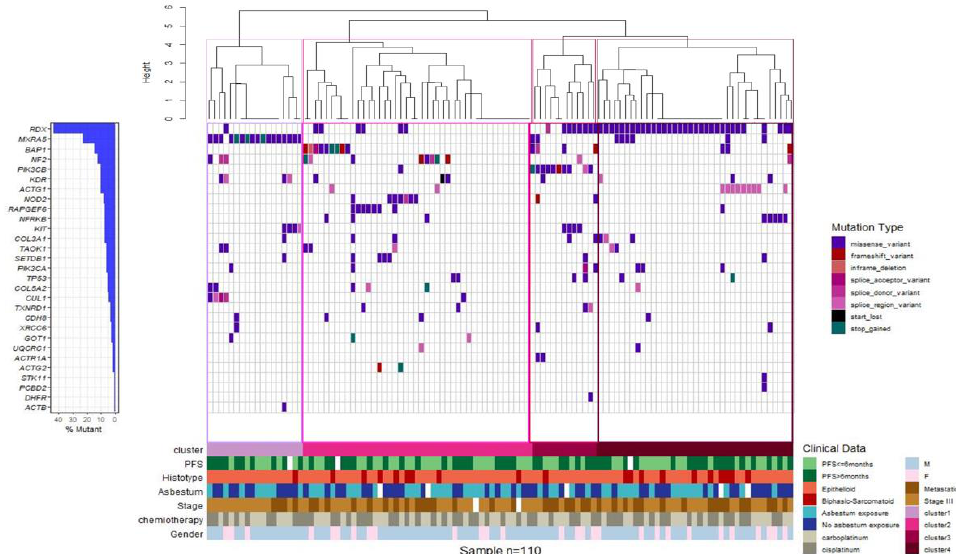
Figure 5. Gene expression-based clustering shows four molecular subgroups. Clustering of MPM cases based on the mutational status. Waterfall plot summarizing the gene variants detected in each patient (columns). Colored squares indicate mutation types. Upper histograms represent for each patient the estimated number of mutations per MB, based on 90.875 bps covered by the panel. Colored line at the bottom indicates patients classified in di ff erent genetic